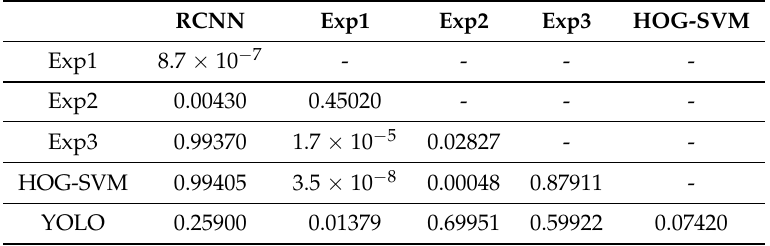
Table 2. Dunn test matrix with the different p-values between methods and